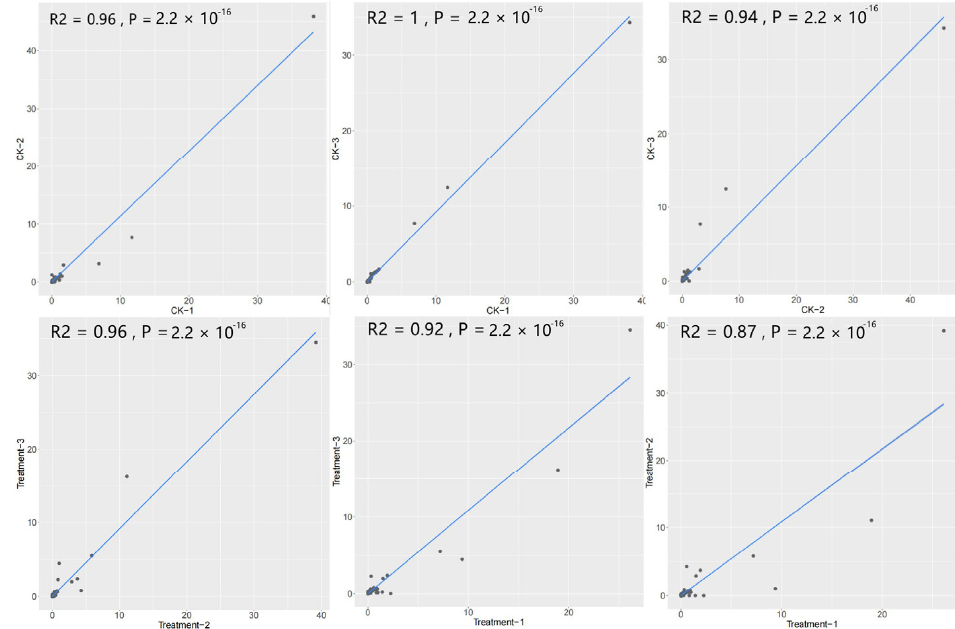
Figure 11. Scatter plot of the different biological repeats with new analysis strategy.